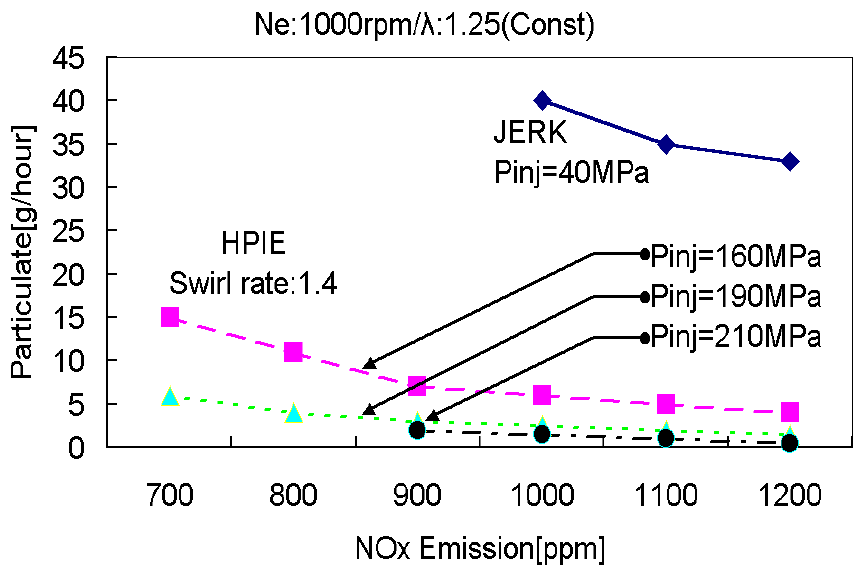
Figure 3. Effects of injection pressure on the exhaust gas.